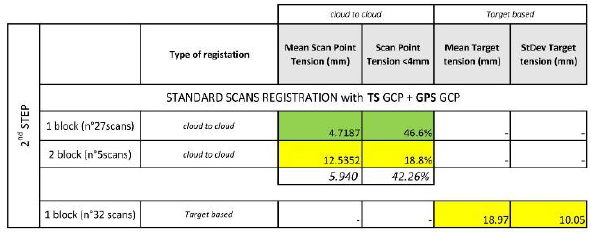
Figure 12. Accuracy results after additional constrains in clouds registration: 2° STEP